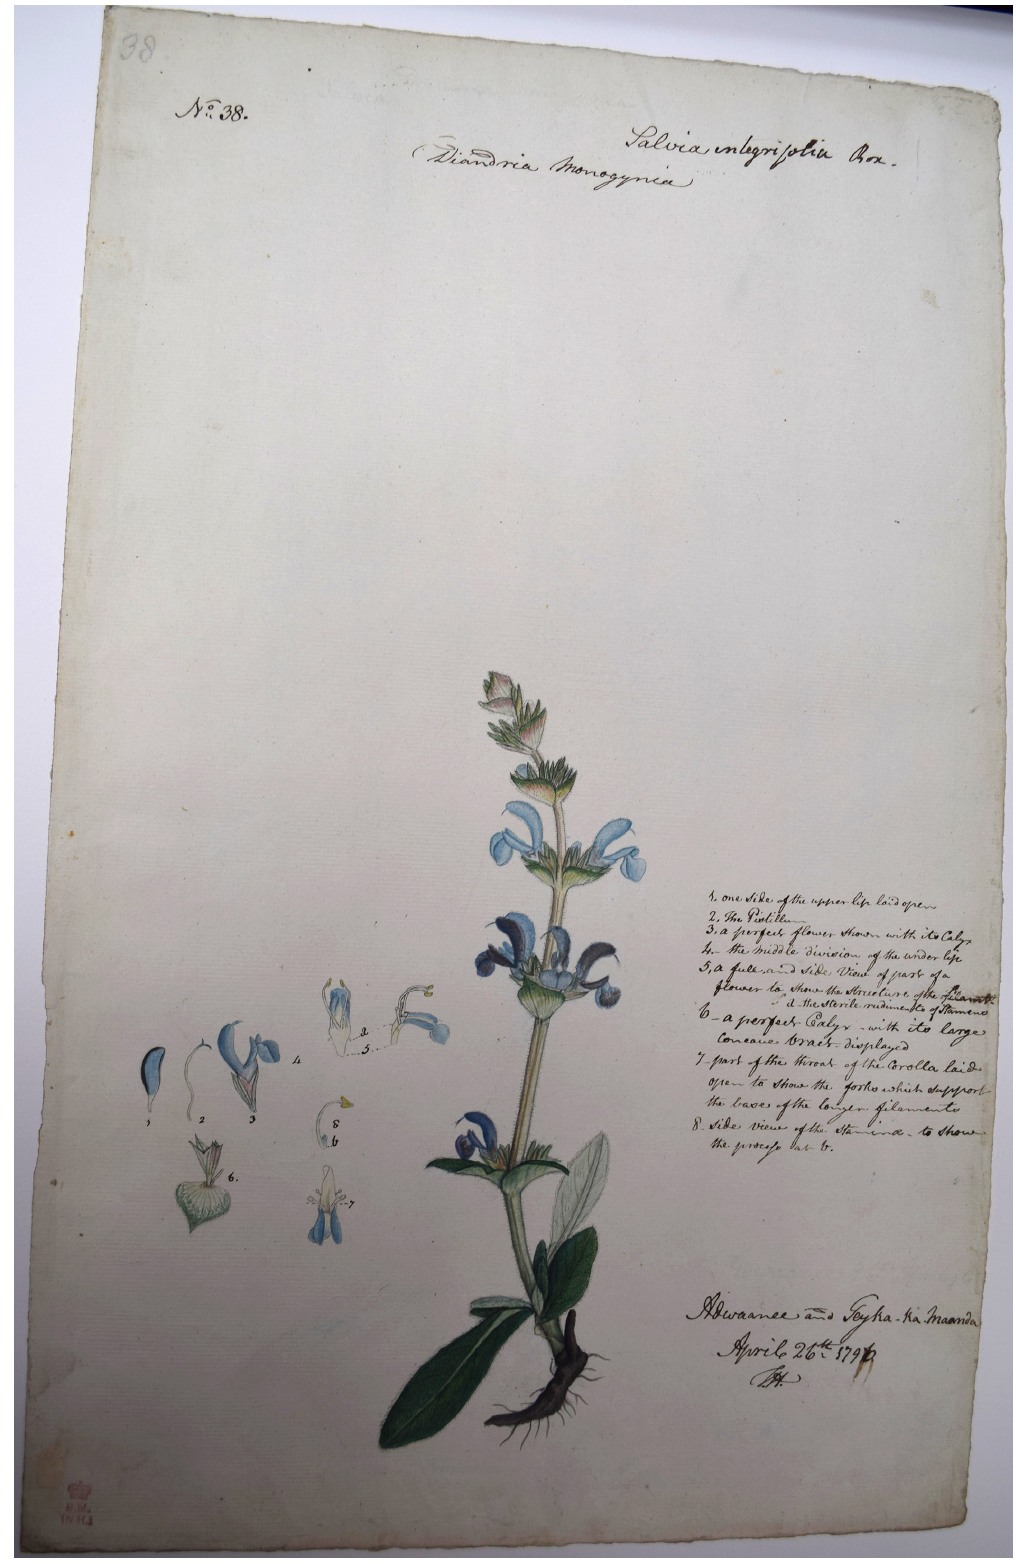
Fig. 2. Lectotype of Salvia integrifolia Roxb. ex Hardw., Hardwicke Drawing no. 38 from the collection of the Botany Library, Natural History Museum. © The Natural History Museum,